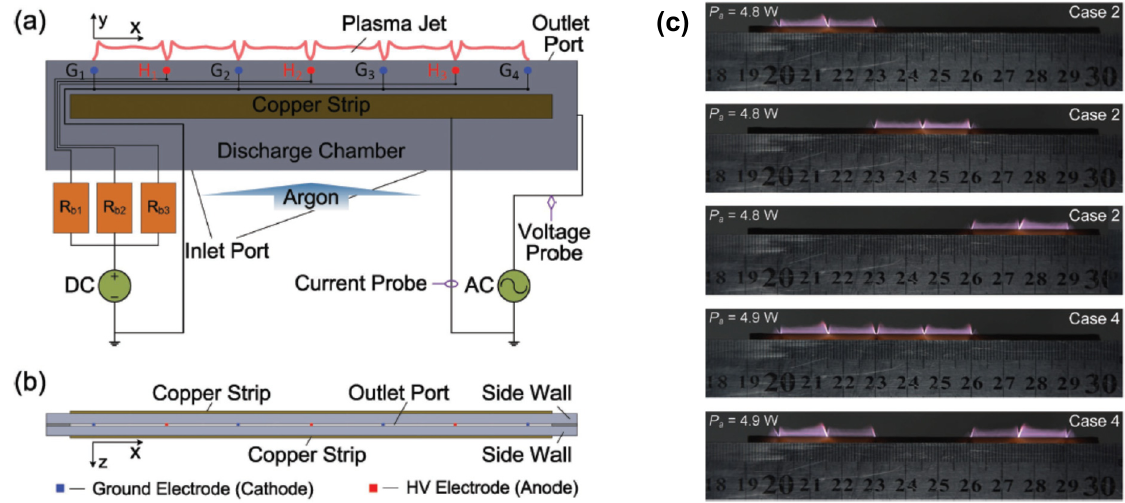
Figure 7. Sketch of a low-voltage laminar discharge array with plasma jets emanating from inde- pendently actuated cells. Each single discharge is controlled by actuating on separate switches. ( a ) Lateral, and ( b ) top view of the device. ( c ) Images of the planar jets striking in couples at different positions with similar values of input power. Reproduced from [43]. Published by Wiley-VCH under the Creative Commons CC BY license.